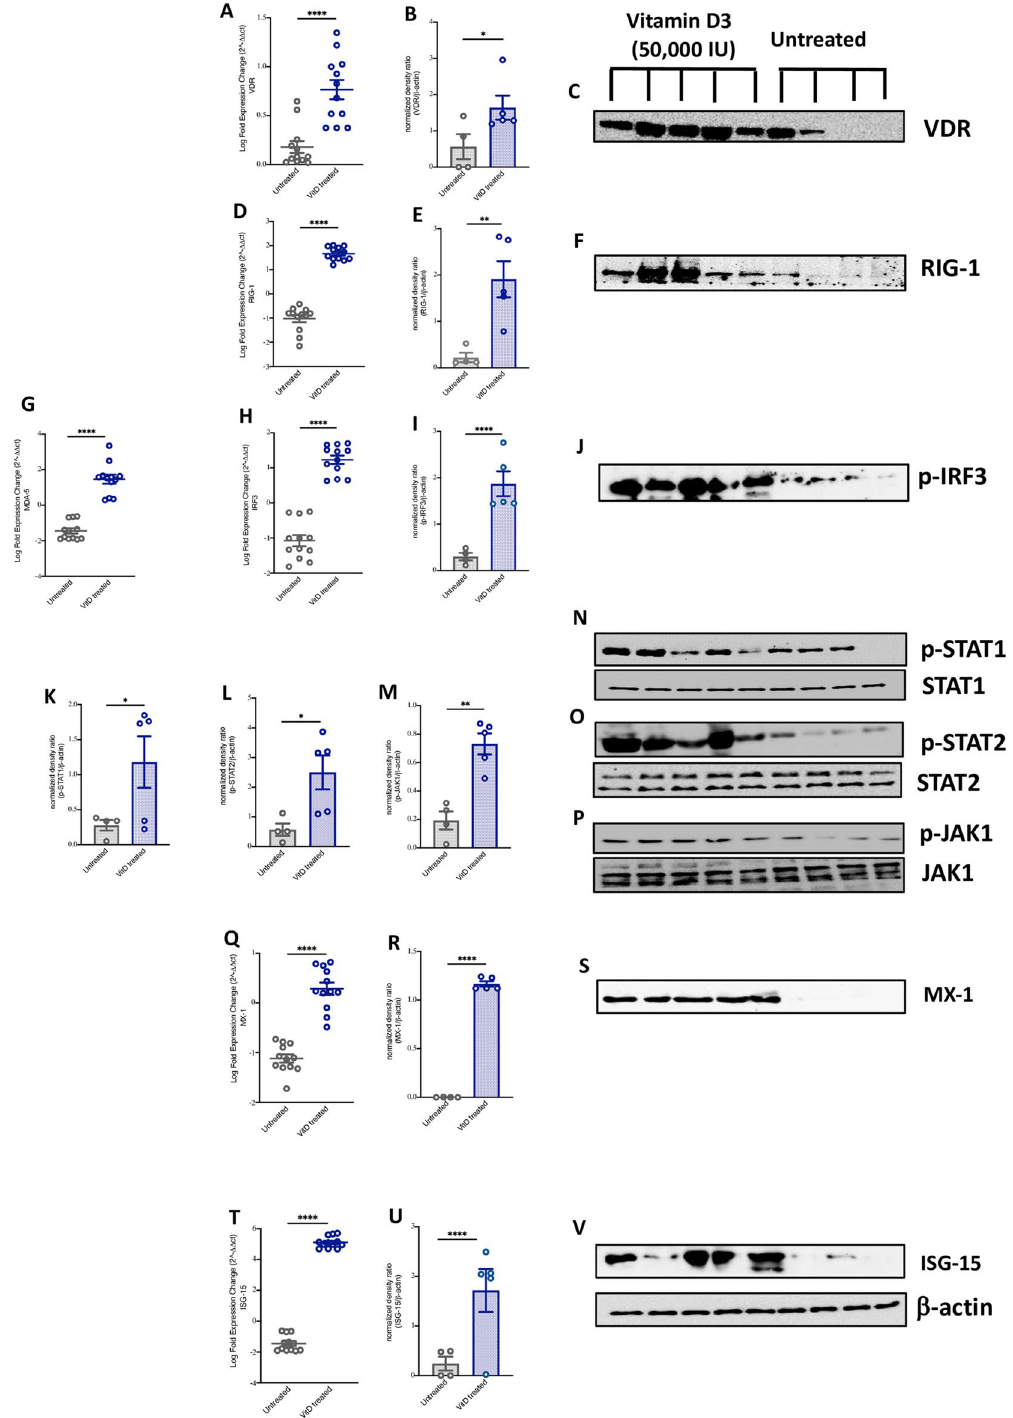
Figure 3. Increased IFNα/β signaling in saliva of VitD treated COVID-19 patients. ( A – C ) The mRNA and protein levels of VDR in saliva of VitD treated (cholecalciferol was administrated as 50,000 IU weekly) and untreated COVID-19 patients. ( D – J ) The mRNA levels of RNA cytosolic sensing proteins, such as RIG- 1, MDA5, and p-IRF3 in saliva of VitD treated and untreated COVID-19 patients. ( K – P ) Protein levels of p-STAT1, p-STAT2, and p-JAK1 in saliva of VitD treated and VitD untreated COVID-19 patients. ( Q – V ) The mRNA levels of ISGs such as MX-1 and ISG-15 in saliva of VitD treated and VitD untreated COVID-19 patients. The saliva of VitD treated (n = 5; 3 males and 2 females) and untreated COVID-19 patients (n = 4; 2 males and 2 females) were randomly chosen from cohorts of VitD treated (n = 43; 36 males and 7 females) or untreated (n = 37; 27 males and 10 females) COVID-19 patients. Statistic test: comparison was done using unpaired t-test or Mann–Whitney U test, depending on the skewness of the data. *P < 0.05, **P <